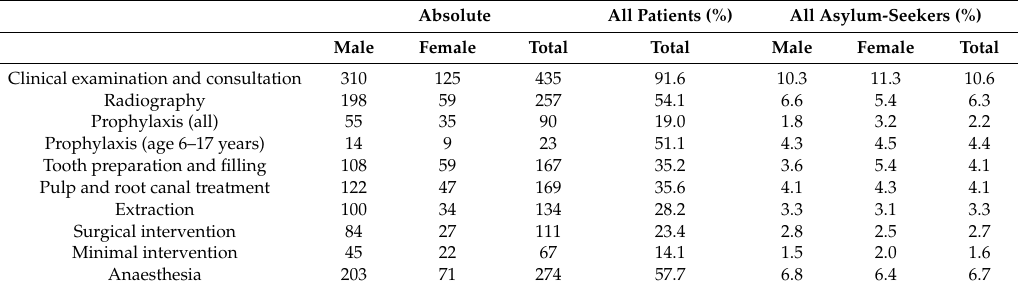
Table 3. Frequency of treatment procedures *.